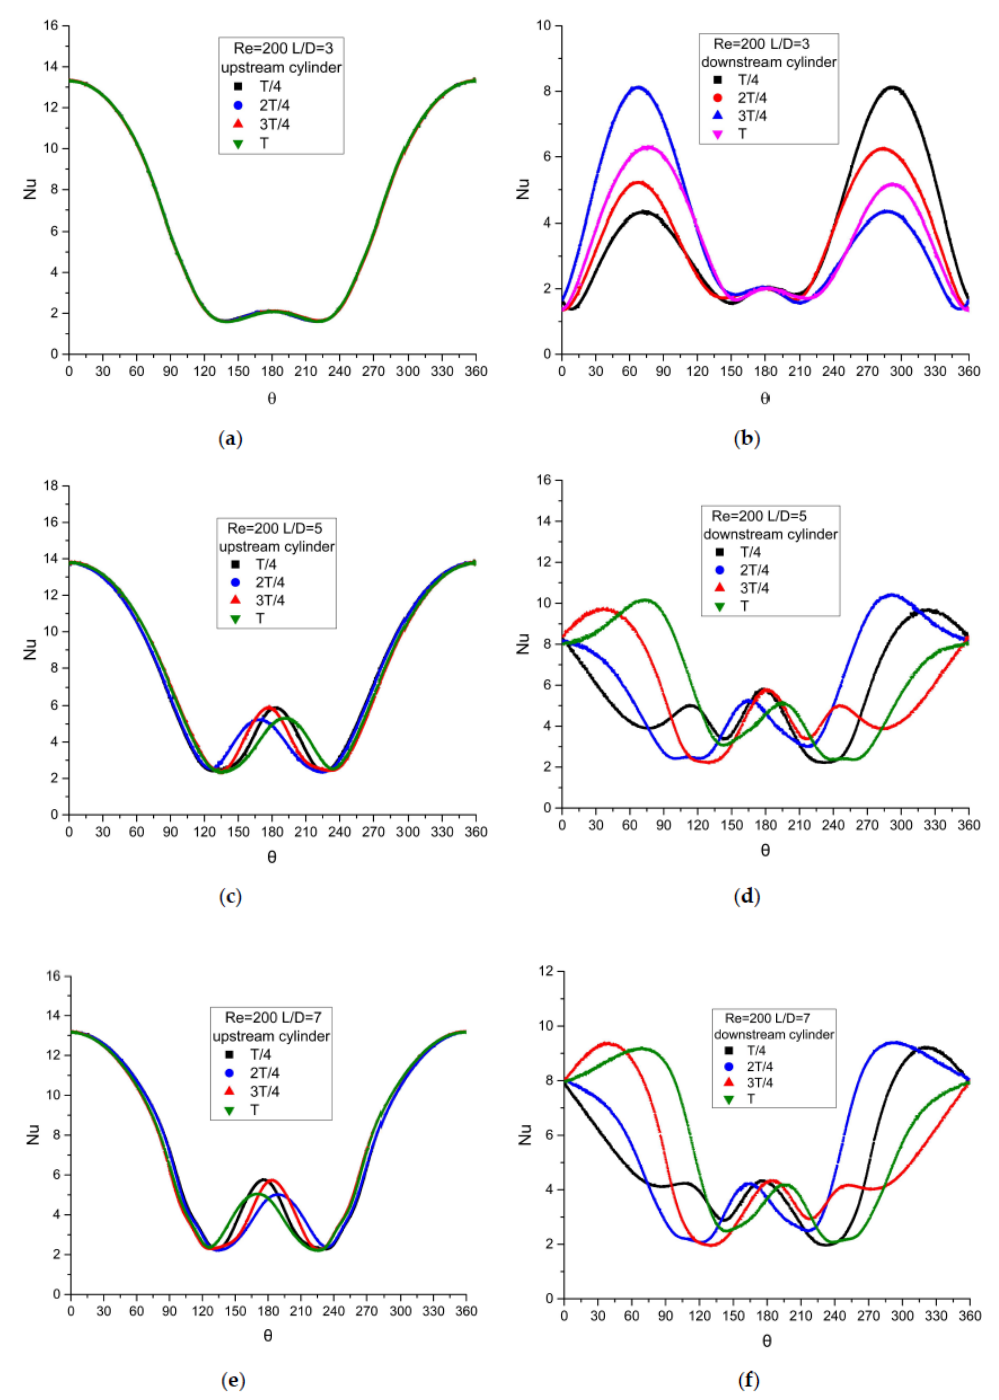
Figure 11. Transient Nusselt number distribution of the co-shedding pattern, Re = 200: ( a , b ) L/D = 3; ( c , d ) L/D = 5; ( e , f ) L/D = 7.